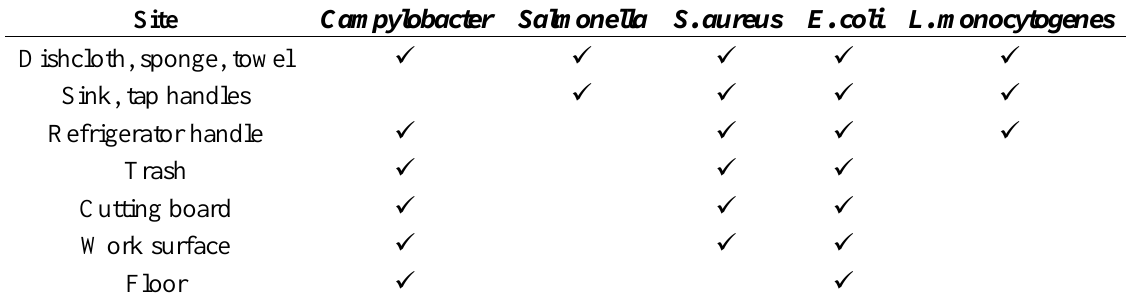
Table 2. Key pathogens found on frequently touched areas of the home kitchen *